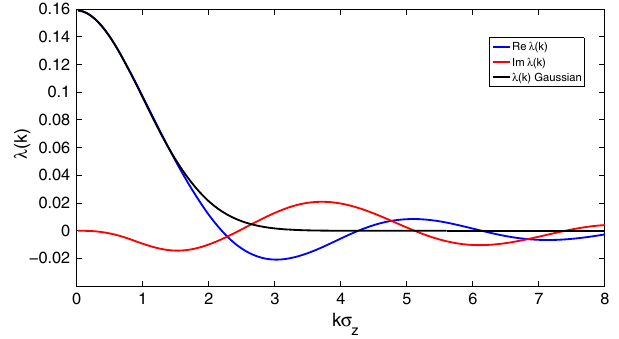
ˆ λ ð k Þ of the simulated form of the . z